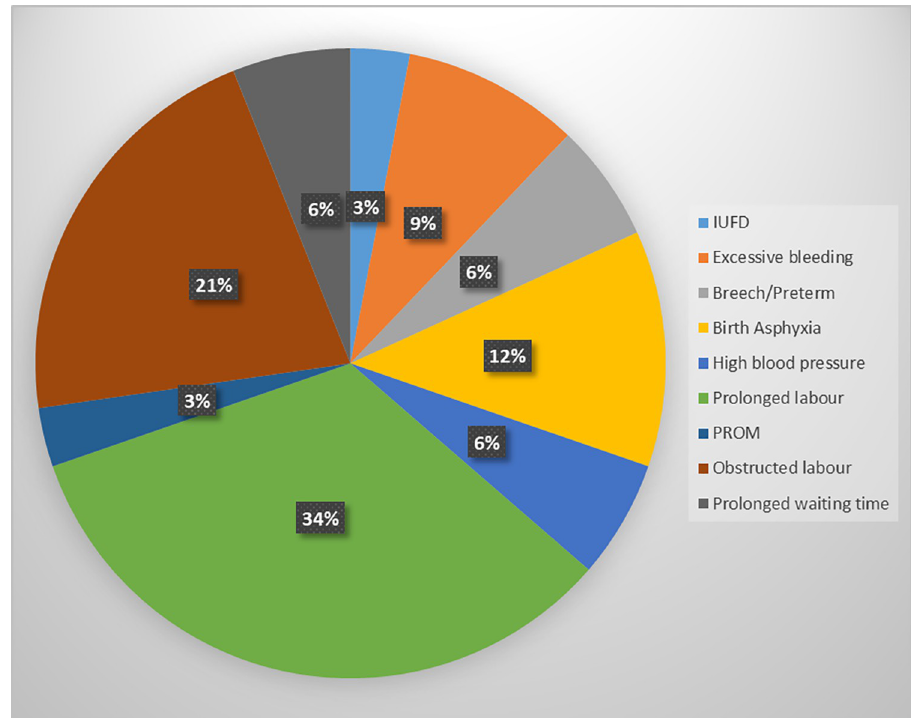
Fig 1. Reported birth